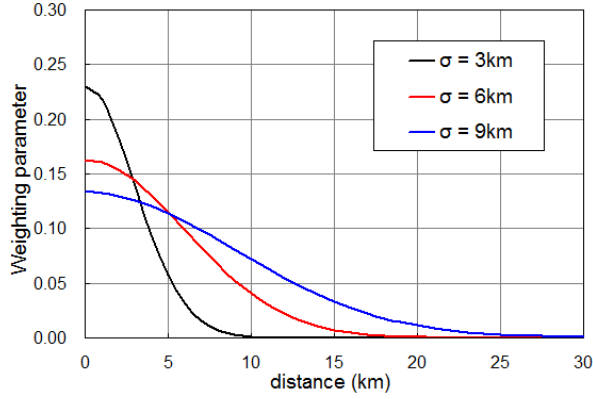
Figure 5. Exponential weighting parameter for the variability of σ .